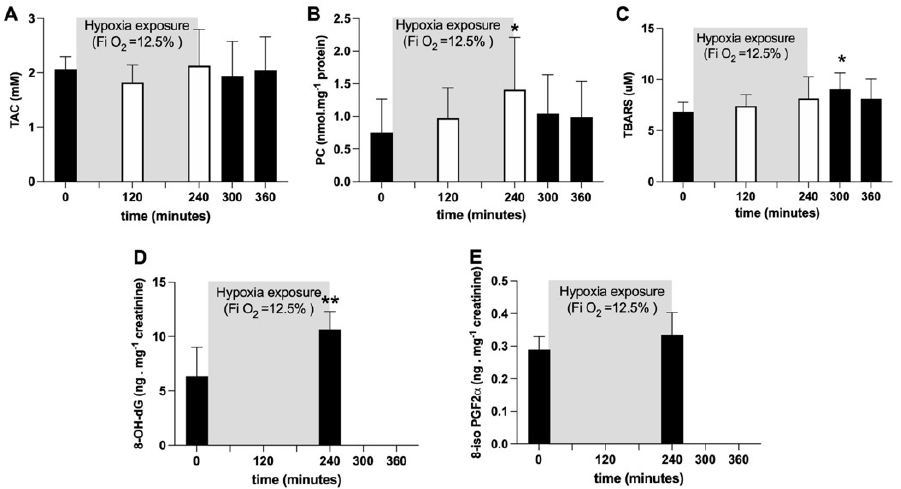
Figure 2. Histogram plots (mean ± SD) of ( A ) TAC (mM), ( B ) TBARS ( µ M) and ( C ) PC (nmol · mg − 1 protein) concentration levels obtained from plasma samples collected at 0, 120 and 240 min of NH. Data at 60 and 120 min of the recovery time, when breathing normoxic room air, are also shown. ( D ) 8-OH-dG and ( E ) 8-iso-PGF2 α (ng · mg − 1 creatinine) data levels before and after NH. Changes over time were significantly different when compared to pre-exposure levels (* p < 0.05; ** p < 0.01 symbols).